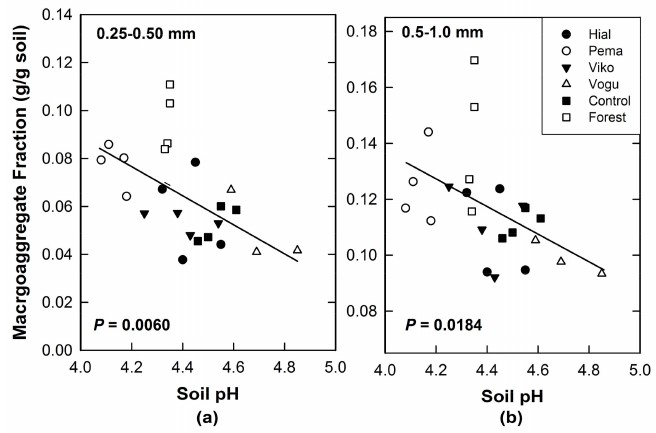
Figure 5. Correlations between soil pH and C contained in macroaggregates. ( a ) Data are for the smallest size fractions, 0.25–0.50 mm and ( b ) Size fractions 0.5–1.0